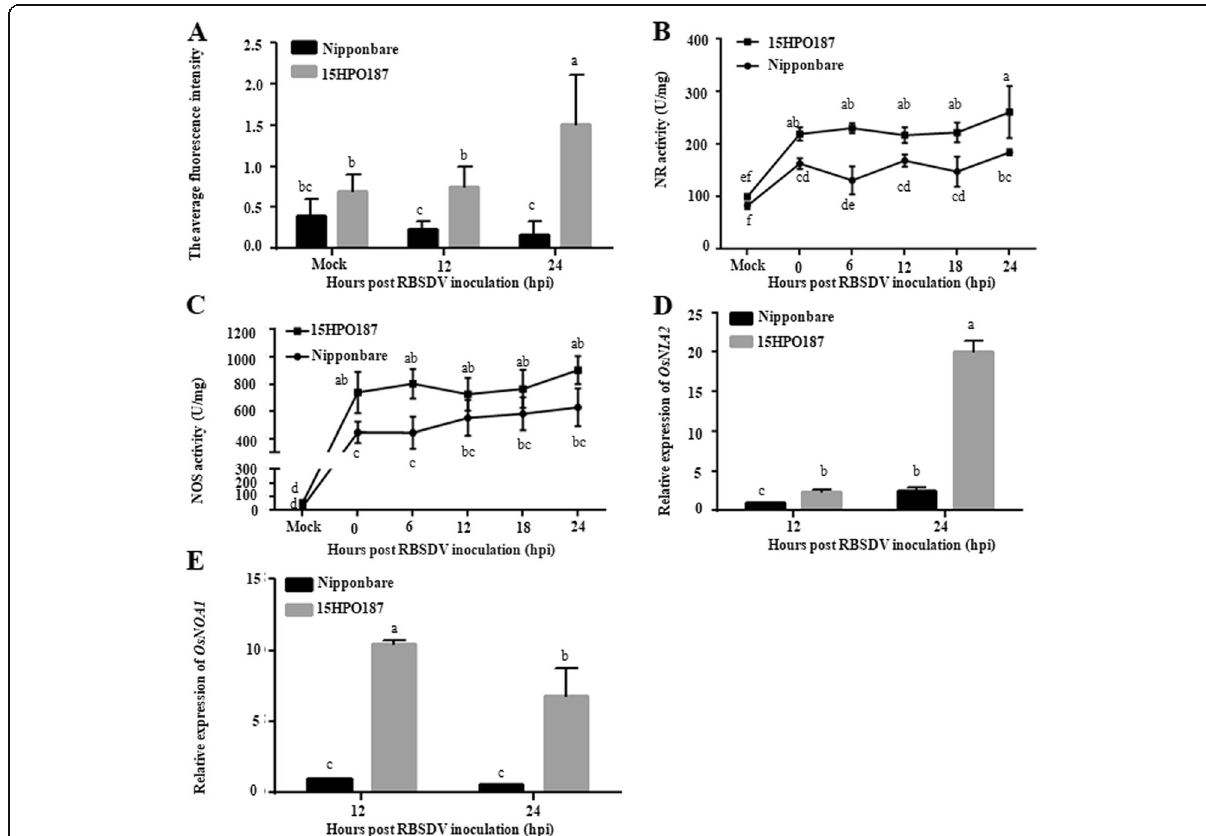
Fig. 2 Function of endogenous NO in RBSDV infection. a Endogenous NO accumulation in the RBSDV-inoculated Nipponbare or 15HPO187 plants at various hpi. Ten plants were analyzed as ten biological replicates. The data represented the means ± SD of the ten replicates. Entire experiment repeated 3 times with similar results. b and c Activities of nitrate reductase (NR) and mammalian NO synthase (NOS)-like enzyme in the RBSDV-inoculated plants at various hpi. Ten plants were pooled together as one biological experiment. Images are representative of three independent biological experiments. The data represented the means ± SD of the three replicates. d and e Expressions of OsNIA2 and OsNOA1 in the RBSDV-inoculated plants at various hpi. Five plants were pooled together as one biological experiment. The data represented the means ± SD of the three biological replicates. Entire experiment repeated 3 times with similar results. Different low case letters above the bars indicate the statistical differences between the treatments using the Duncan ’ s multiple